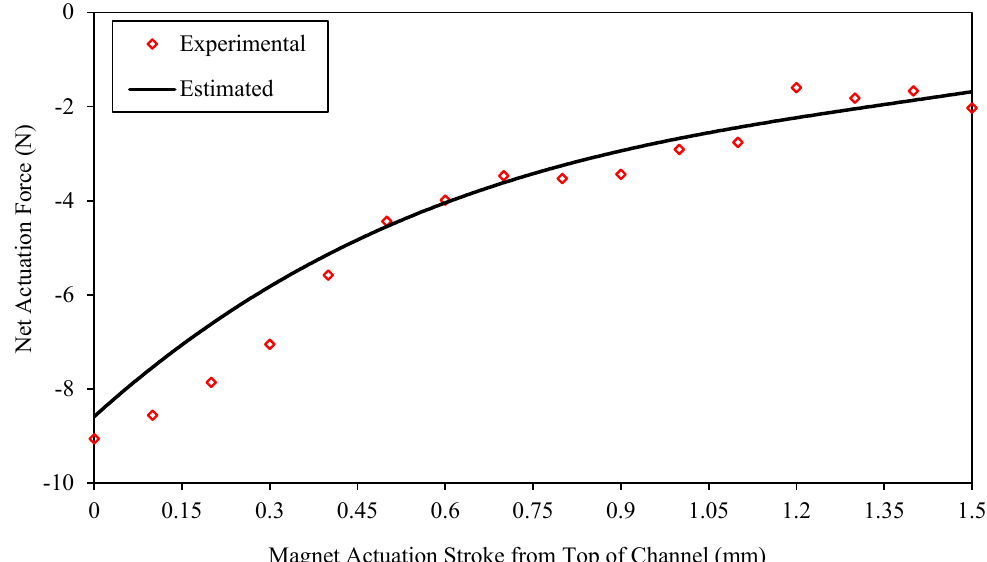
Figure 18. Net repulsion force on the magnet from the top to the lower end of channel during the activation state of the coil.